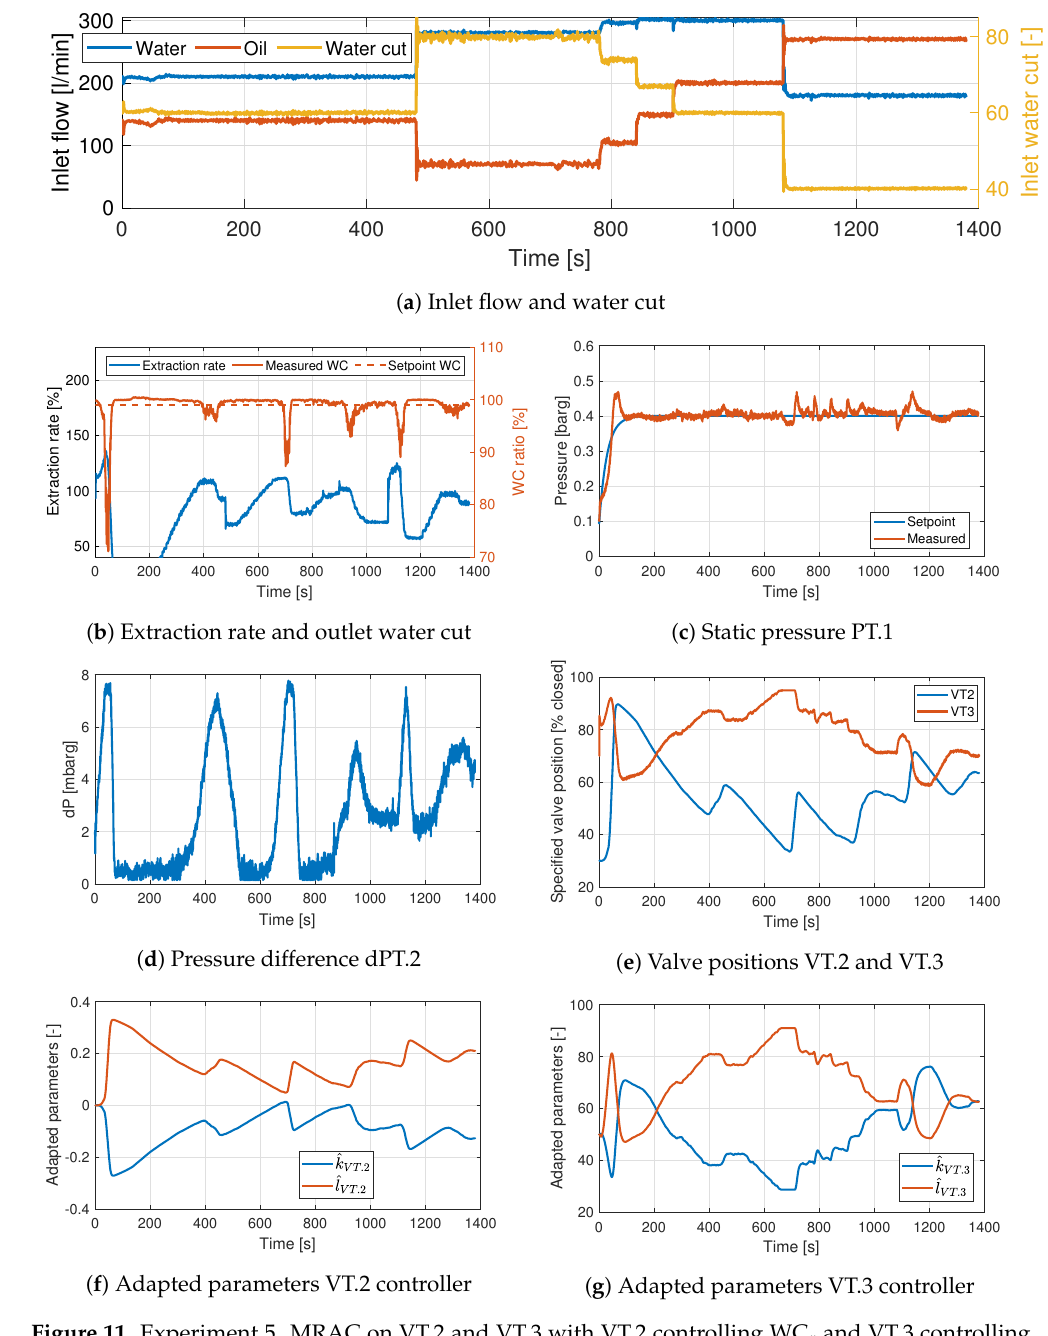
Figure 11. Experiment 5. MRAC on VT.2 and VT.3 with VT.2 controlling WC r and VT.3 controlling PT.1, as recommended by the RGA